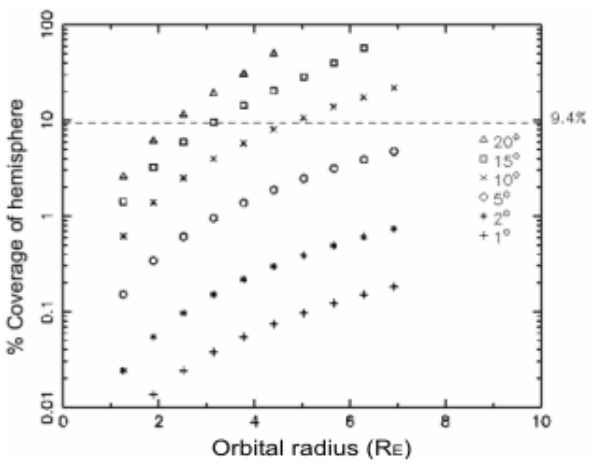
Fig. 2 . WFAI module schematic. Note that planar windows and filters may be substituted for Fig. 1 . Percentage coverage of a hemisphere of the Earth versus orbital radius for FOV values Fig. 1. Percentage coverage of a hemisphere of the Earth versus filters may be substituted for the curved elements shown here. Ap-